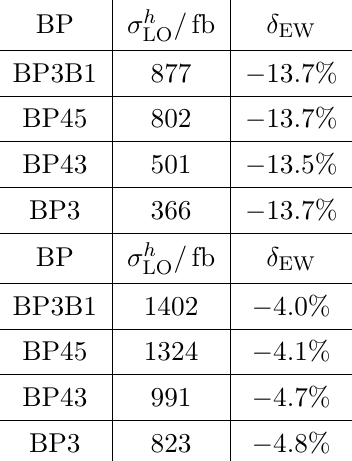
Table 15. Relative NLO corrections (cid:14) EW to Higgs-boson production in Higgs strahlung pp ! H l (cid:22) (cid:0) (cid:22) + in the upper table and VBF pp H l =H h jj in the lower table in the SM. The Higgs-boson ! mass M h is set to the heavy Higgs-boson mass M H in the corresponding benchmark point. h HSESM and 2HDM in ref. [103], where it is stated that for small mixing angles, near the alignment, new operators do not play a signi(cid:12)cant